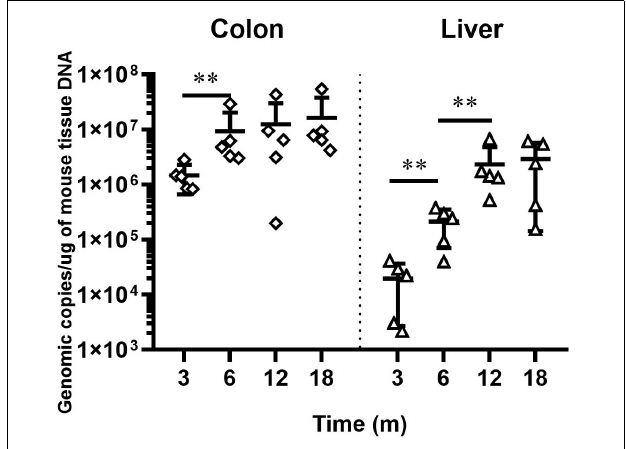
FIGURE 1 | QPCR-based quantitation of the Helicobacter hepaticus cdtB gene in intestinal and hepatic segments. Copy numbers of the H. hepaticus genome are expressed per micrograms of mouse DNA in the respective samples. The samples of control groups negative for H. hepaticus are not shown. ∗∗ p < 0.01 as compared to the control. Each group contained five